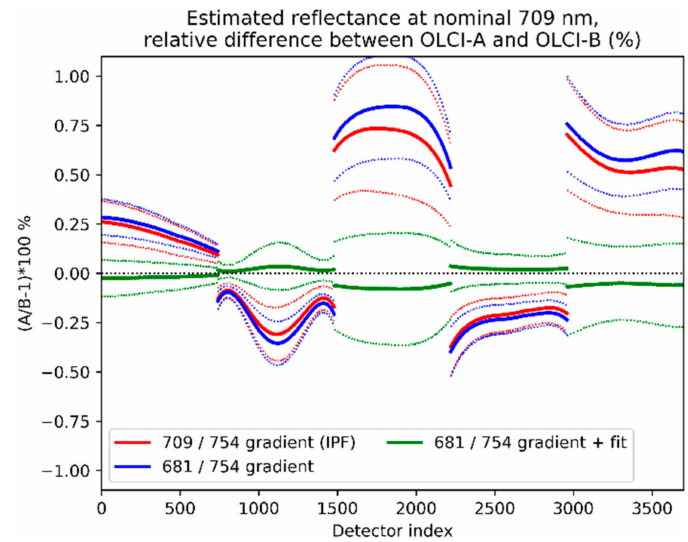
Figure 11. Relative di ff erences between estimations of the vegetation reflectance at 709 nm using OLCI-A and OLCI-B ISRFs (plain lines) using two pairs of channels (709 / 754 nm and 681 / 754 nm), in green is used the fit from Figure 10. Simulations based on the ECOSTRESS spectral library [28,29]. Dashed lines indicate standard